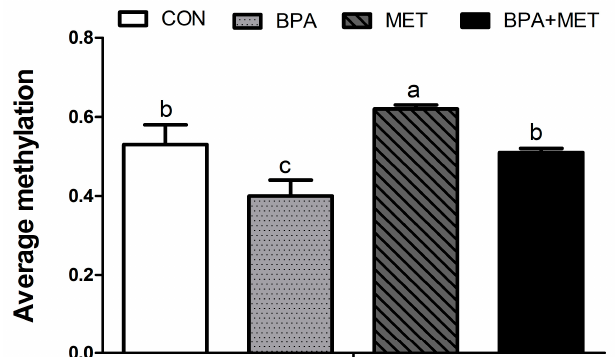
Figure 1. Effect of maternal methyl donor or bisphenol A supplementation during gestation on the jejunum Pept1 gene DNA average methylation level in newborn pigs. CON, control; BPA, bisphenol A; MET, methyl donor; BPA + MET, both bisphenol A and methyl donor supplementation in control diet. Values are expressed as mean ± standard error; different superscript letters within a row indicate significant difference ( p < 0.05). Four independent samples per treatment group (total 16).